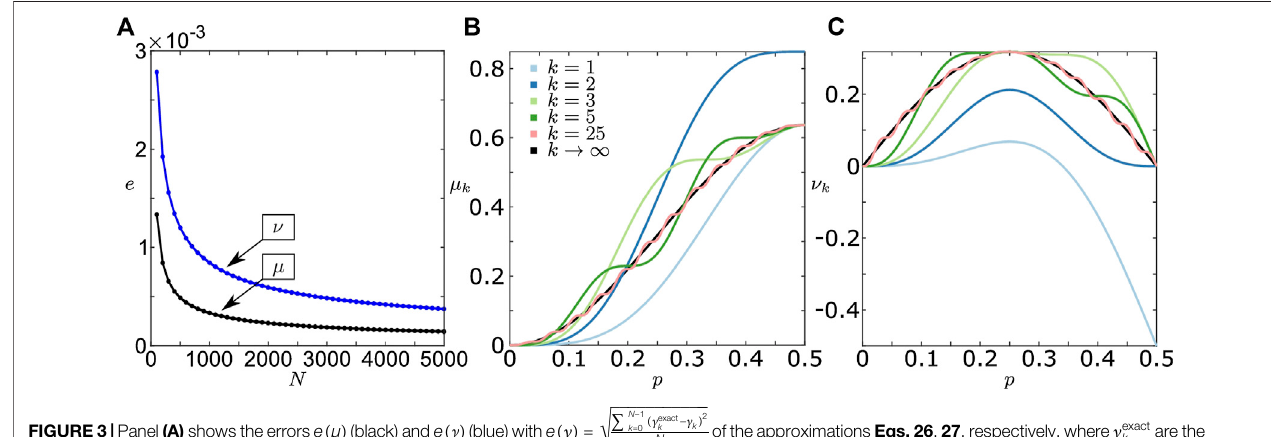
(cid:28)(cid:28)(cid:28)(cid:28)(cid:28)(cid:28)(cid:28)(cid:28)(cid:28)(cid:28)(cid:28)(cid:28) (cid:29) (cid:5) ​ N − 1 ( c exact − c k ) 2 oftheapproximations Eqs. 26 , 27 ,respectively,where c exact k arethe k k (cid:1) 0 N